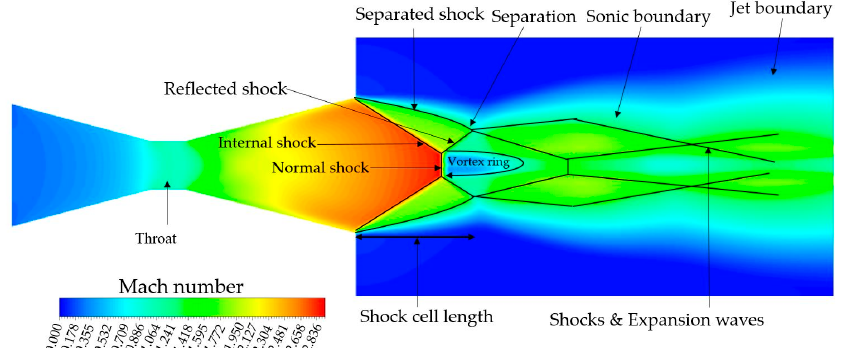
Figure 13. The Mach number at 1.2 s.